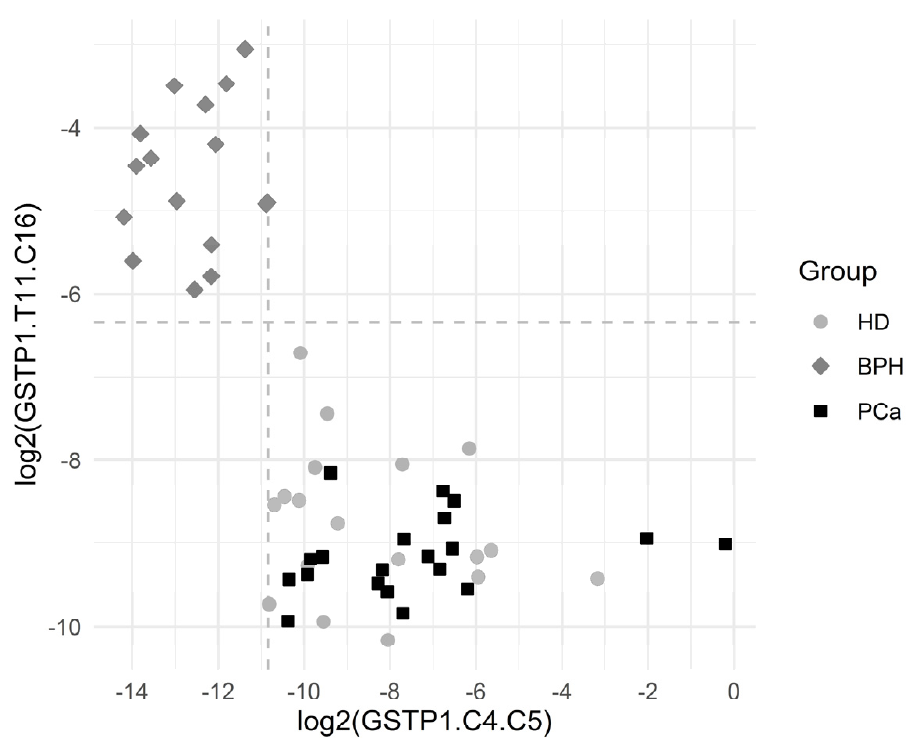
Figure 4. Graphical representation of the BPH group separation. The horizontal dashed line depicts the cutoff value log2(0.0214). The vertical dashed line depicts the cutoff value log2(0.000548). Both the cutoff values correspond to the complete separation of BPH vs. others for the respective variables. One observation from the BPH group with log2(GSTP1.C4.C5) = 0 and log2(GSTP1.T11.C16) = − 3.1 is not depicted, since log2(GSTP1.C4.C5) is infinite for that point. The cutoff value was an estimate for the threshold which may be good for separating the comparison groups. The corresponding ratio was reported in the case of complete separation, which was the ratio of the minimum in the comparison group with higher values to the maximum in the comparison group with lower values.